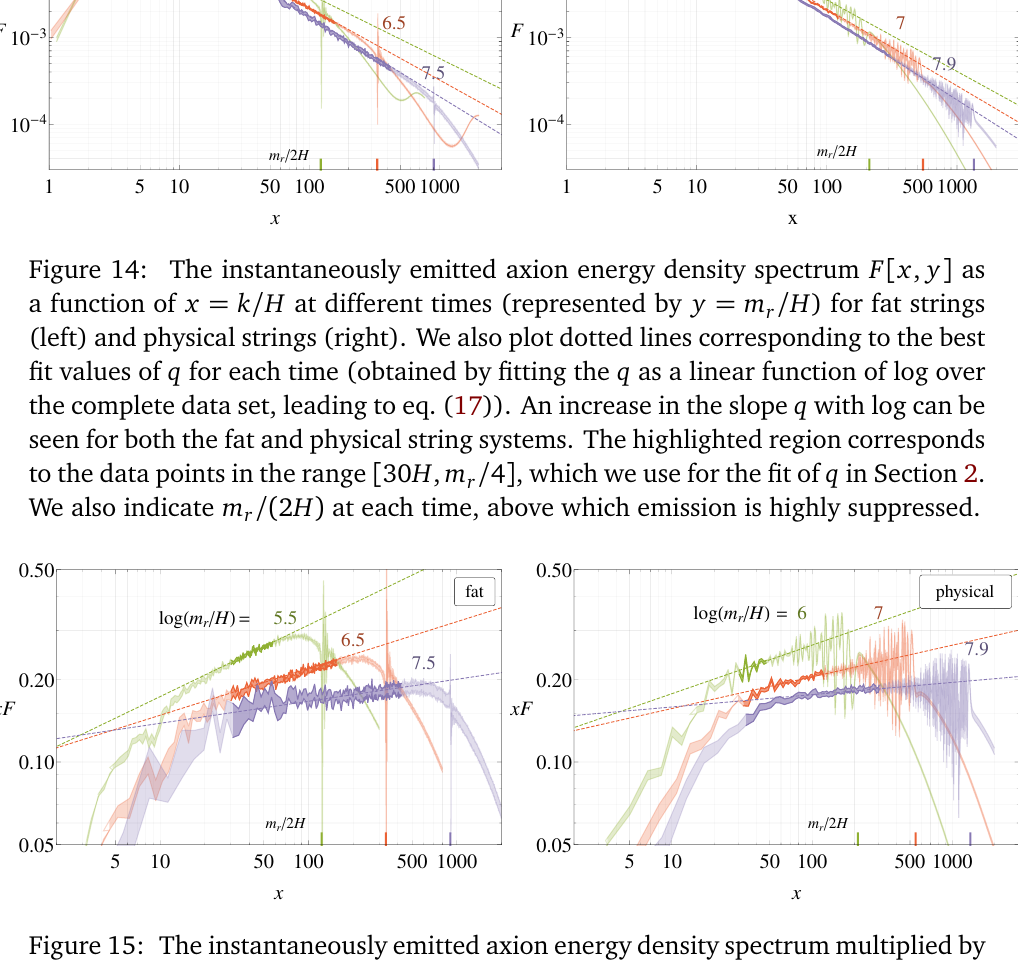
Figure 15: The instantaneously emitted axion energy density spectrum multiplied by x , i.e. xF [ x , y ] , as a function of x = k / H and at different times for fat strings (left) and physical strings (right). The increase in q is evident and at the final time the instantaneous emission is almost scale invariant ( q = 1). It is reasonable to expect that at log (cid:39) 8 the slope q will overtake the value q =